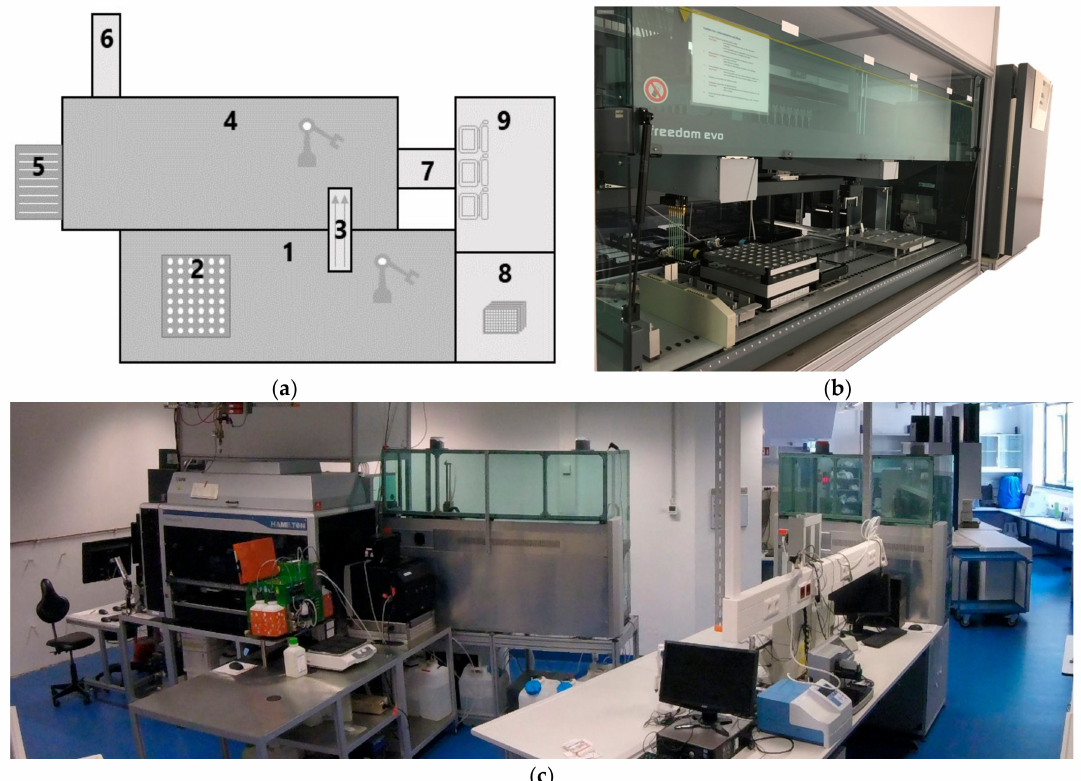
Figure 3. The robotic HT platform for cultivation in 48 MBRs and automated sampling and analysis. Shown are the Tecan LHS including the MBR system, the Hamilton LHS connected by a linear transfer unit. ( a ) Scheme of the robotic platform with 1-Tecan EVO 200, 2–bioREACTOR48 system, 3-Linear transfer unit, 4-Hamilton Microlab STAR, 5-SynergyTM MX Plate Reader, 6-MACS Quant Analyzer 10, 7-FAME incubator, 8-CytomatTM 6004 DR, 9-monitoring and control station, ( b ) robotic platform facing the Tecan Evo 200 with bioReactor48 system, ( c ) HT lab facing the Hamilton Microlab